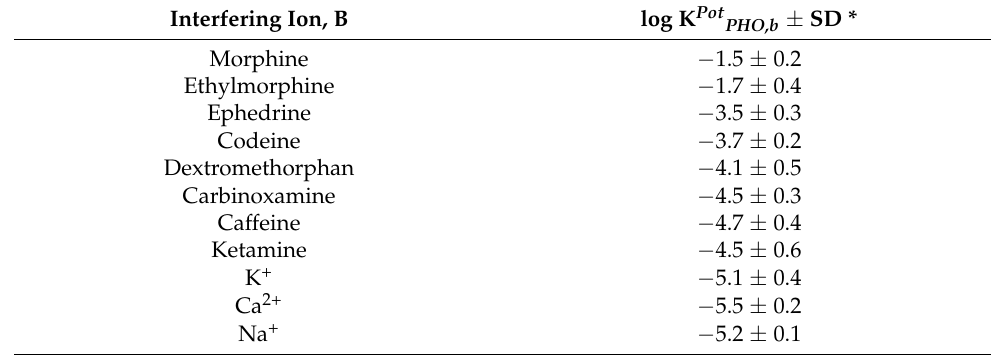
Table 1. The selectivity coefficients (log K Pot PHO,B ) of